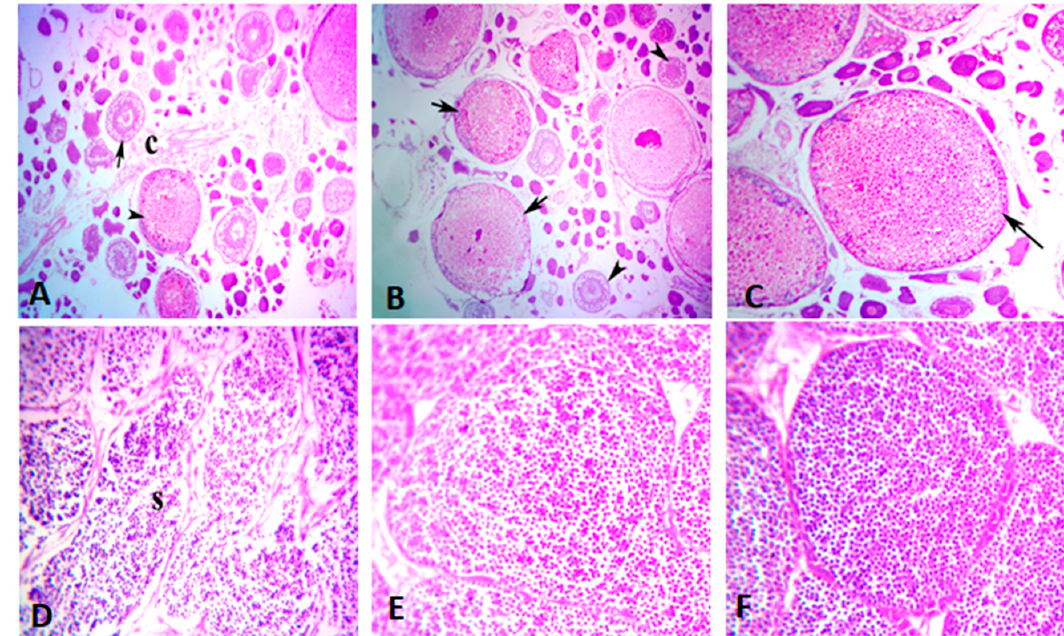
Figure 1. Photomicrographs of H&E-stained ovary ( A – C ) and testes ( D – F ) of C. auratus, fed cacao bean meal (CBM) for 60 days. ( A ) The control treatment showed normal ovary tissue structures with nearly normal previtellogenic follicles with or without oocytes (arrow), and limited maturation follicles that have yolk are deposited in the cytoplasm (arrowhead) surrounded by interstitial limit connective tissue ( C ) at 5×. ( B ) Fish fed CBM5 showed the normal structure of the mature stage of the oocyte (arrows) and different developmental stages of oocytes (arrowheads) at 10×. ( C ) CBM10 fed fish showed that the ovary becomes more developed and reached the final maturation (ripe oocytes) stage (arrow) at 10×. ( D ) Testes of fan goldfish fed CBM0 showed normal testicular seminiferous lobules engorged with spermatozoa (S), spermatogonia, and intra seminiferous lobules connective tissues at 10×. ( E ) Fish fed CBM5 diet showed histological maturation of testis with the normal structure of seminiferous tubules full of spermatocytes, spermatozoa, and spermatids at 10×. ( F ) Fish fed CBM10 showed the seminiferous tubules filled with sperms in the mature stage at 10×.